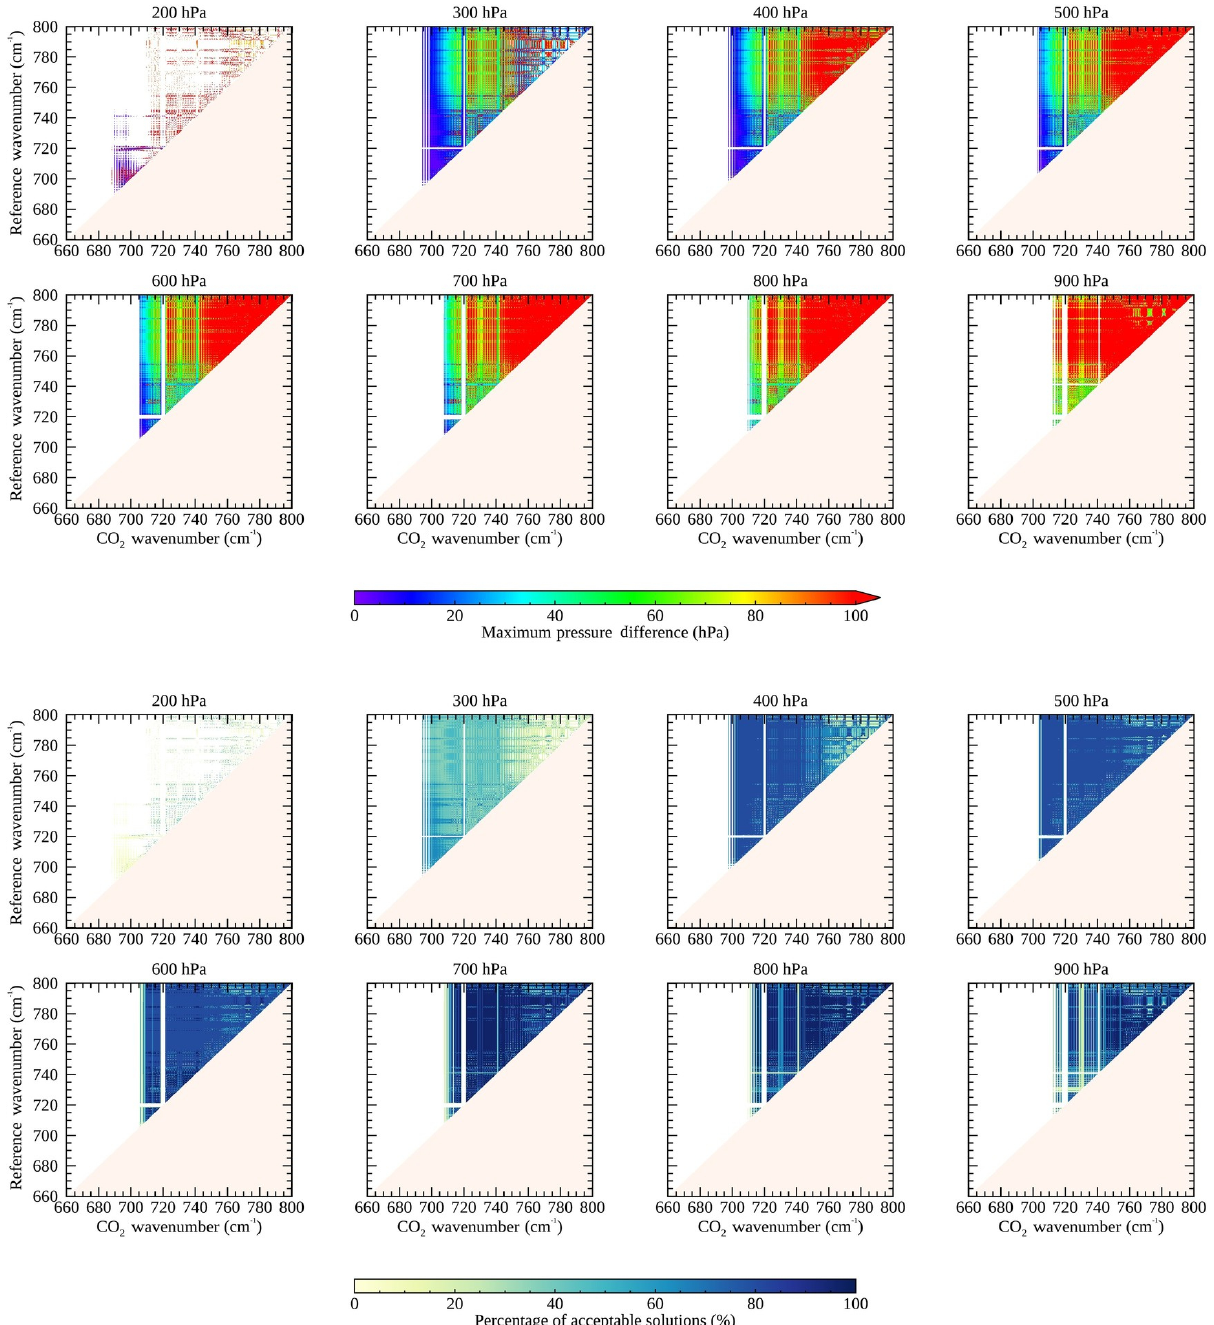
Figure 3. CO 2 slicing results for simulated ash spectra. The technique has been applied for each channel pair between 660 and 800cm − 1 . A total of 384 spectra were used which includes six different atmospheres. It also includes ash optical depths between 5 and 15, effective radius ranging between 5 and 10µm, and pressures between 200 and 900hPa. The first two rows of the plot show the maximum difference between the known (simulated) pressure and the pressure retrieved with the CO 2 slicing algorithm. This is divided into each pressure level. The last two rows show the percentage of successful retrievals. This is again divided into the eight different pressure levels. In these plots the colour white indicates where no successful retrieval has been made and off-white indicates channel combinations not explored in this